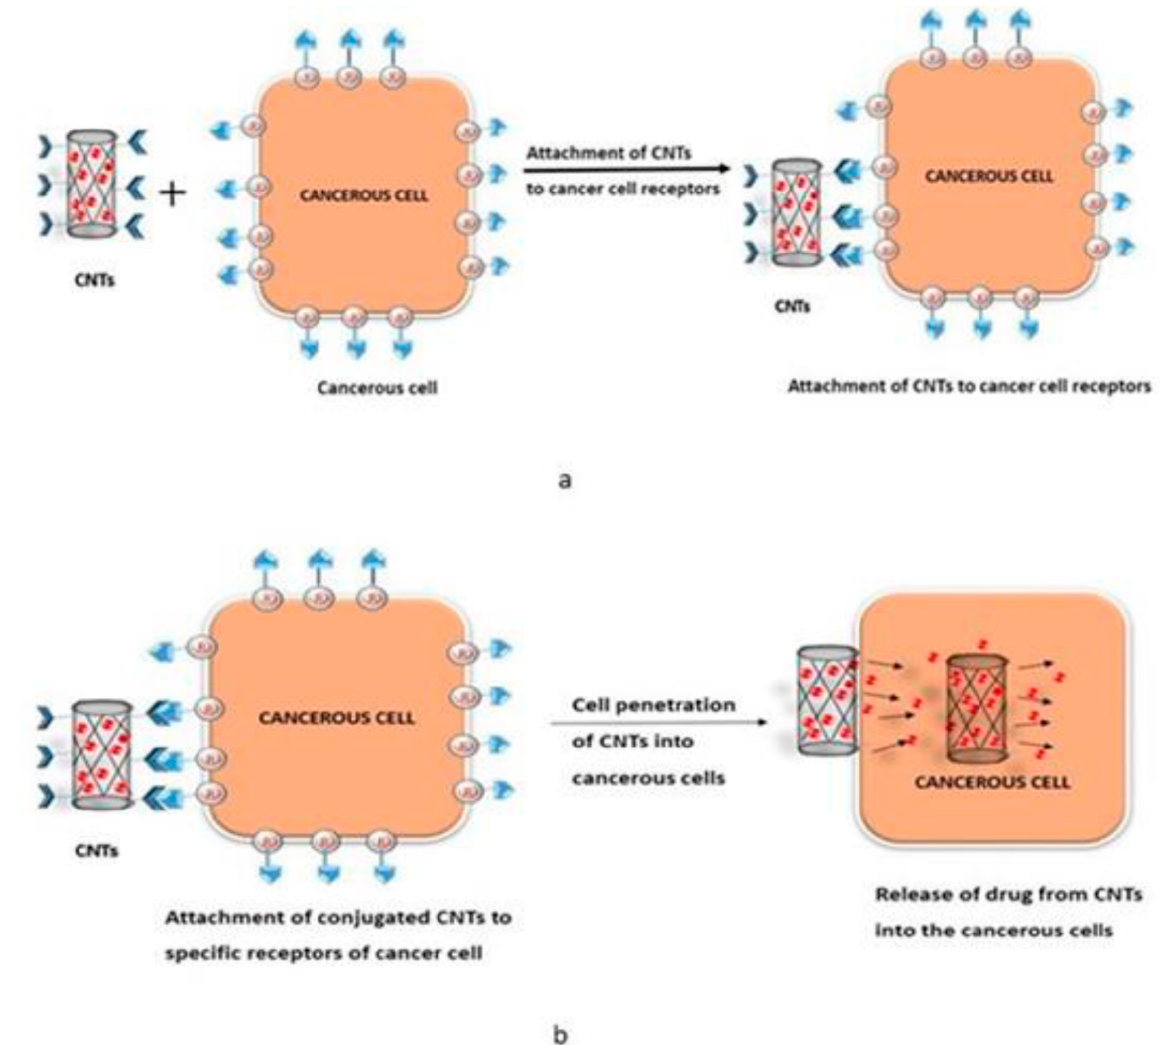
Figure 7. ( a ) Attachment of CNTs to cancer cell receptors. ( b ) Release of drug from CNTs into cancerous